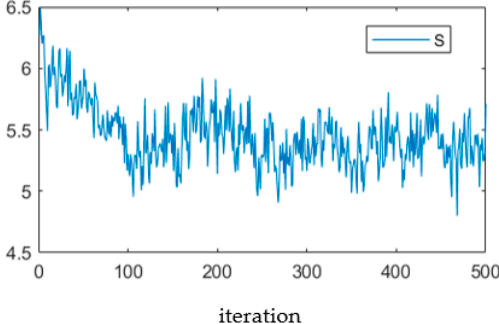
Figure 8. Generation-by-generation population entropy.